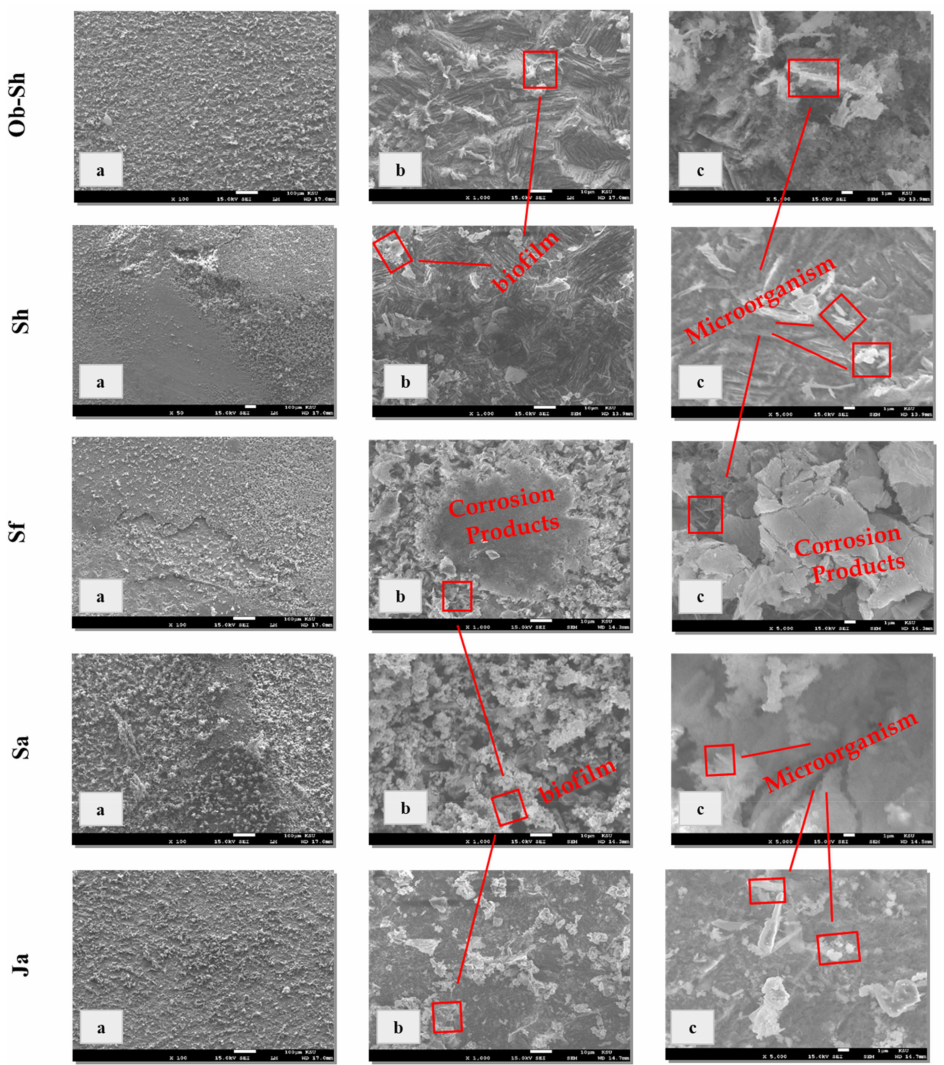
Figure 7. SEM micrographs for CSX36 surface after exposure for 20 weeks of immersion in the studied Jeddah soil solutions at 23 ± 1 ◦ C: ( a ) x = 100 µ m; ( b ) x = 10 µ m; and ( c ) x = 1 µ